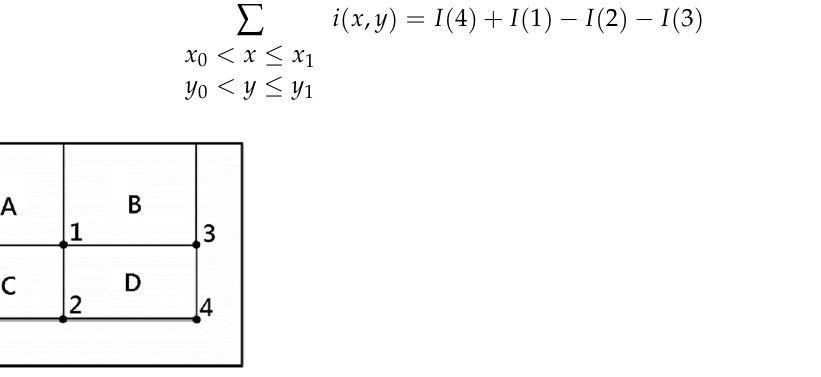
Figure 6. The sum of the pixels within rectangle D can be computed with four array references. Lienhart et al. proposed a novel set to rotate Haar-like features [35]. Their method has two assumptions, one is to assume that the basic unit for testing for the presence of an object is a window of W*H pixels, as shown in Figure 7